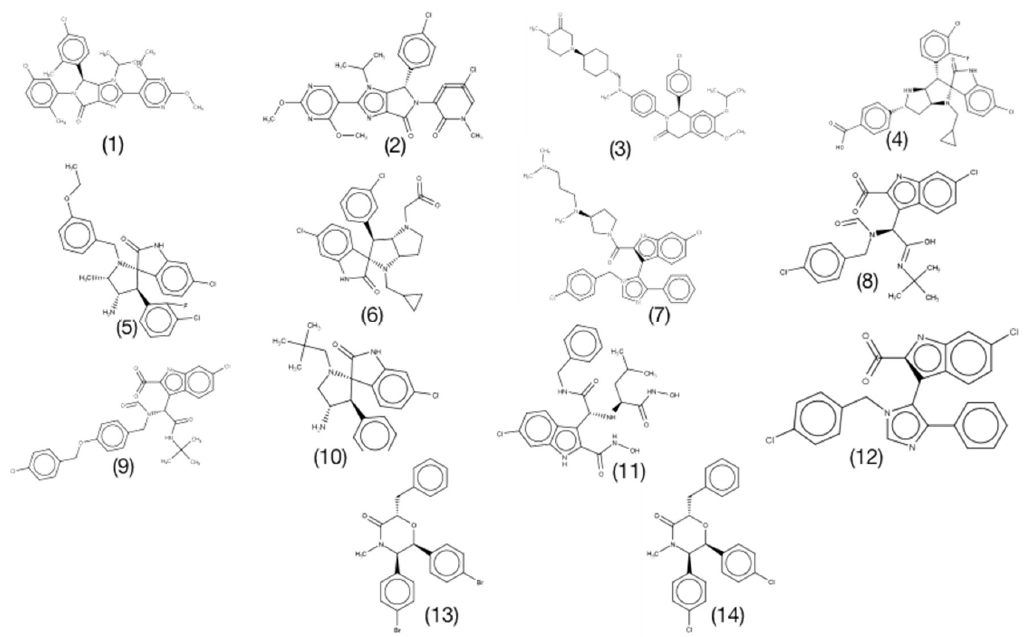
Figure 3. The chemical structure of ligand dataset used for FEP based binding free energy calculations for MDM2 protein. The compounds are listed in table 2.